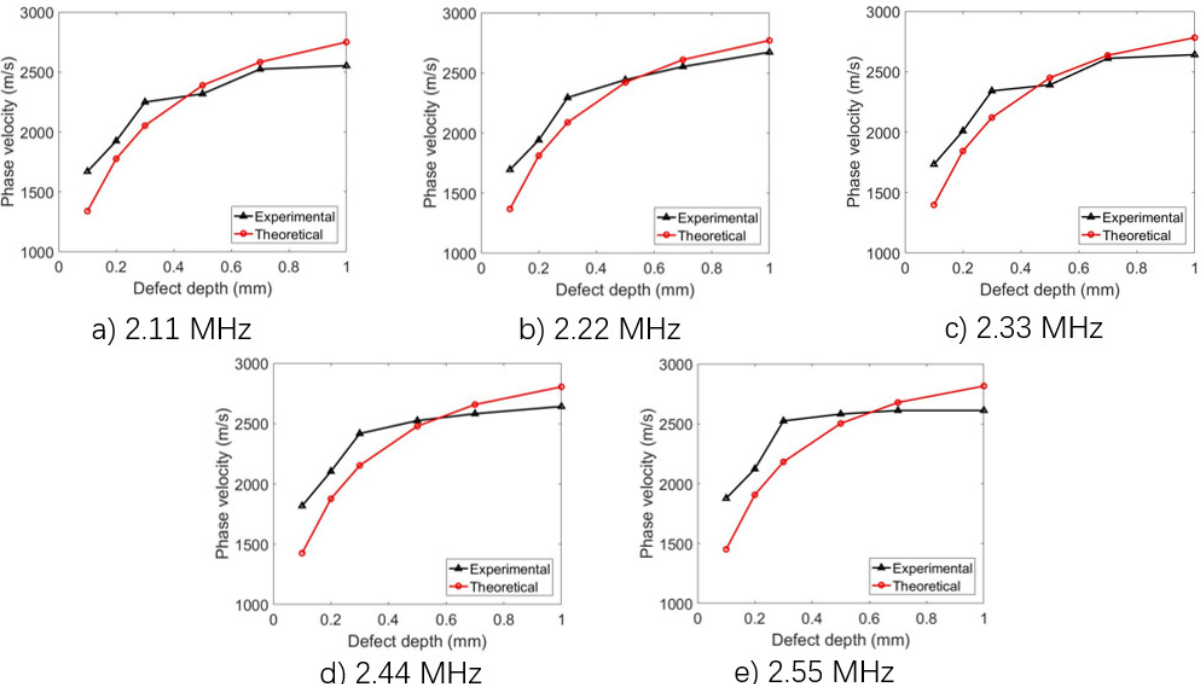
Figure 8. Theoretical and experimental relationship between phase velocity and defect depths at different frequencies: ( a ) 2.11 MHz, ( b ) 2.22 MHz, ( c ) 2.33 MHz, ( d ) 2.44 MHz, ( e ) 2.55 MHz.